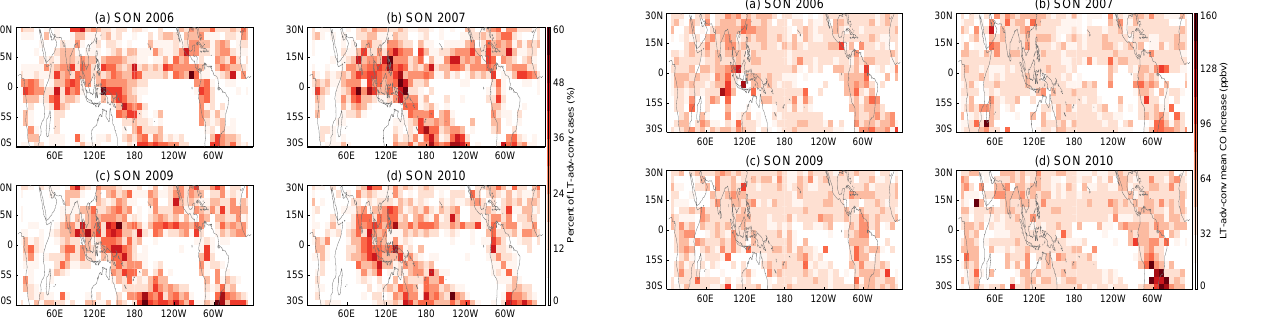
Fig. 11. As in Fig. 10, but for the “LT advection → convection” transport